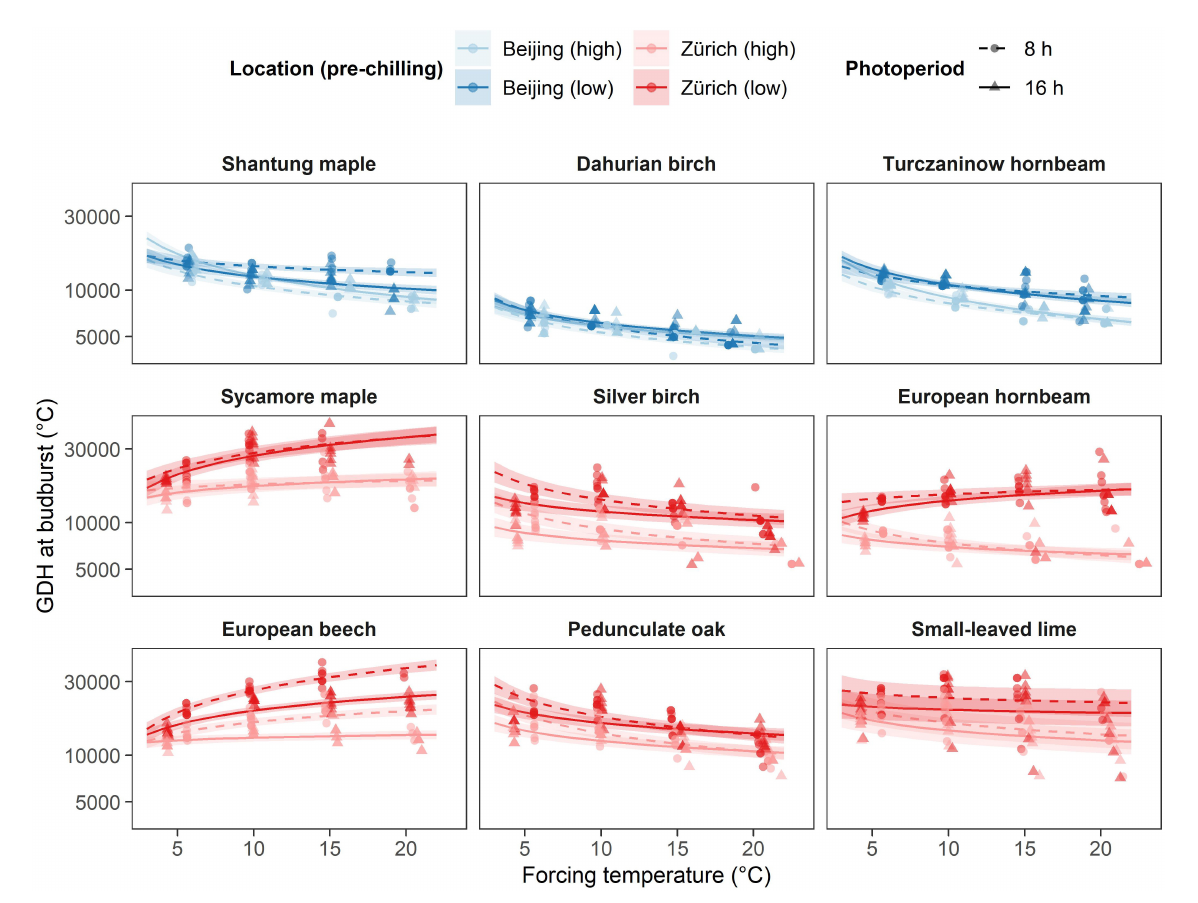
FIGURE3 Effect of the different temperature treatments (forcing) on growing degree hours (GDH) under different pre-chilling conditions and photoperiod. The predicted relationships from the final model are represented as solid lines with corresponding 0.89 credible intervals. Chilling treatments and locations are represented by colors, where blue indicated species growing near Beijing and red indicates species growing near Zurich. Pre-chilling conditions are indicated with lower brightness (high pre-chilling) and higher brightness (lower pre-chilling), whereas photoperiodic treatments are represented by solid lines and triangles (16 h photoperiod) and dashed lines and points (8 h photoperiod).